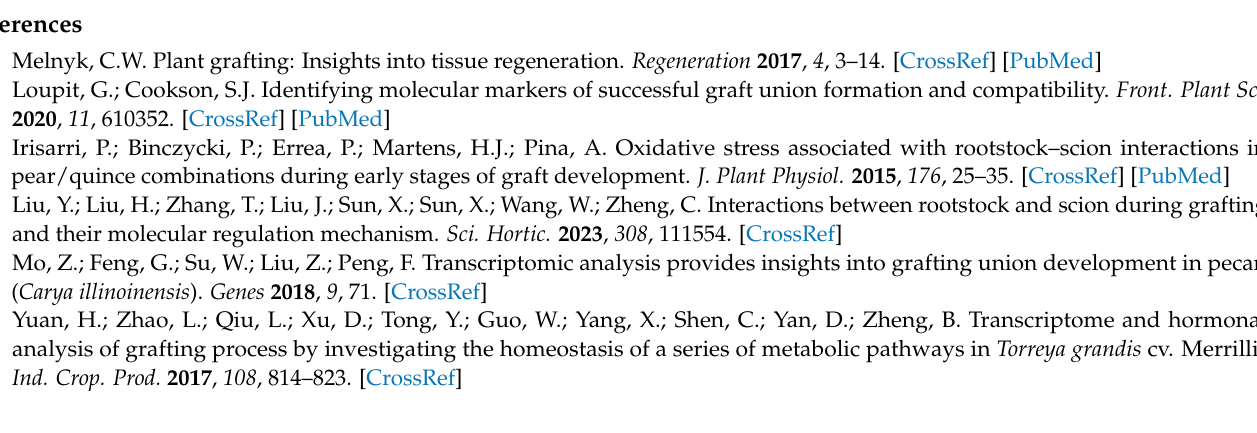
Summary for the RNA-seq; Table S3: Genes with expression variation; Table S4: Hub genes in tan and green modules; Table S5: Summary for genome re-sequencing; Table S6: Hub genes with promoter